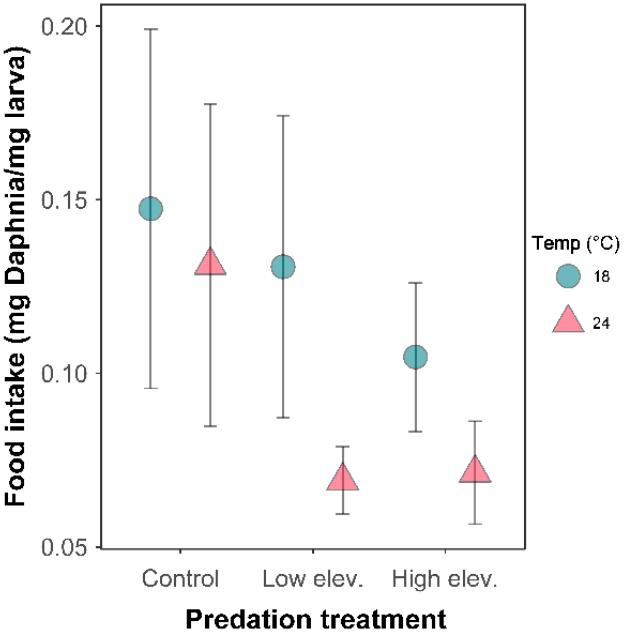
Figure 4. Food intake (corrected for body mass) of Sympetrum striolatum larvae in the combination of two temperature and three predator treatments. Error bars are 95% confidence